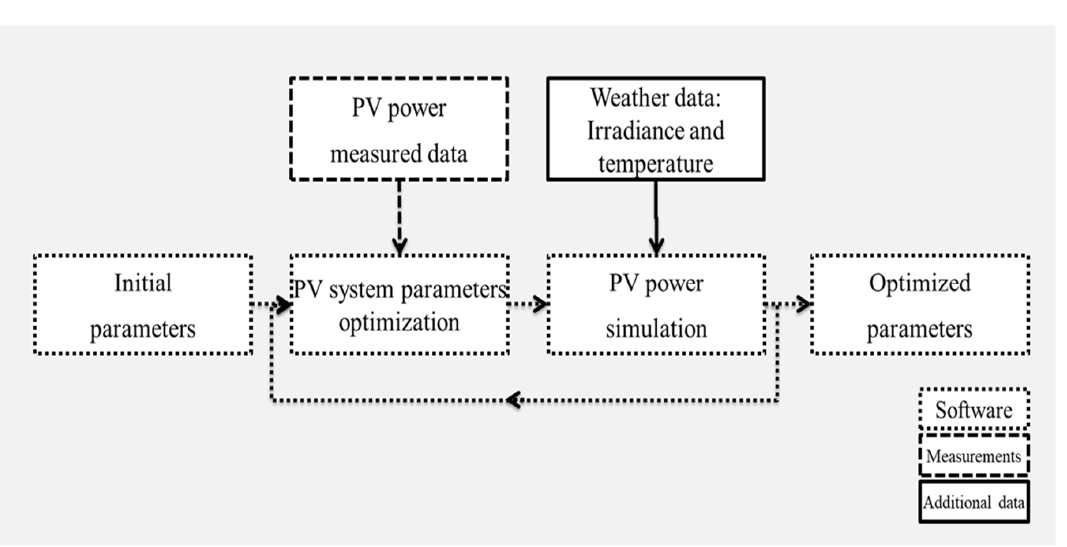
Figure 1. General methodology for the Photovoltaic (PV) system parameters optimization. Small dotted lines represent the interactions between the software blocks. Large dotted lines represent measured PV power data as input. Continuous lines represent additional data required as input, namely meteorological data.